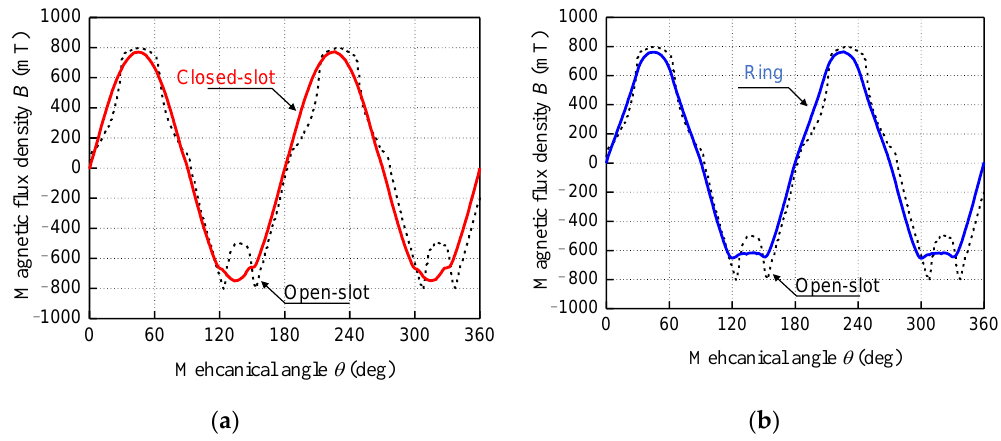
Figure 6. Magnetic flux density at gap ( N = 30,000 rpm, P o = 500 W): ( a ) comparison of open-slot and closed-slot motor and ( b ) comparison of open-slot and ring motor.